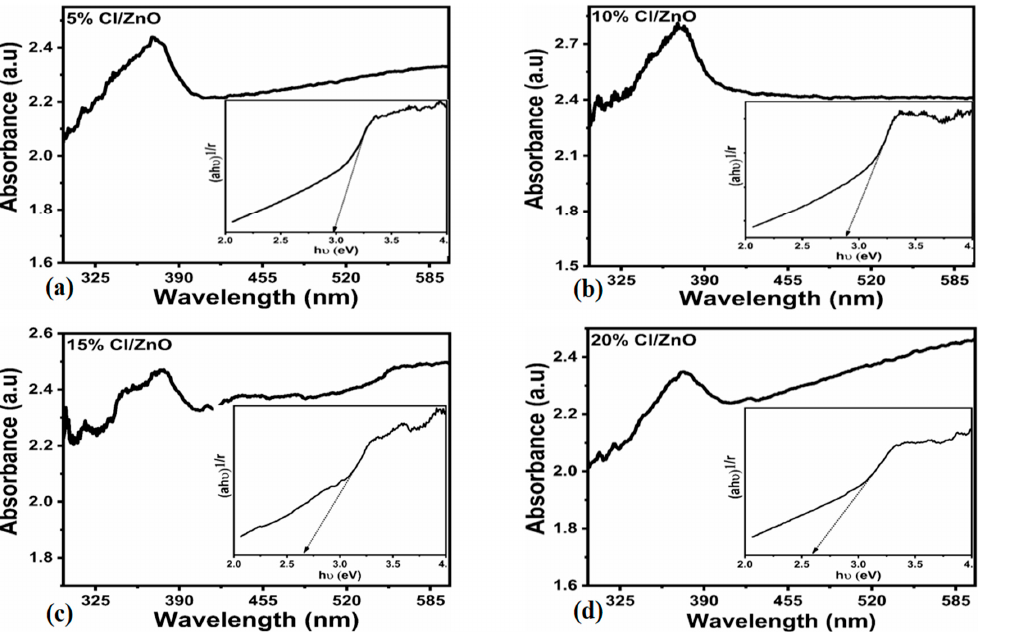
Figure 4. ( a – d ) UV absorption spectra; inset shows the Tauc plot between energy and ( α h ν ) 2 for 5%, 10%, 15% and 20% Cl − -doped ZnO, respectively. Tauc plots of ZnO are shown in the Supplementary Materials (S1c) and Cl − -doped ZnO nanostructures are represented in Figure 4a–d. The insets in Figure 4a–d reveal the